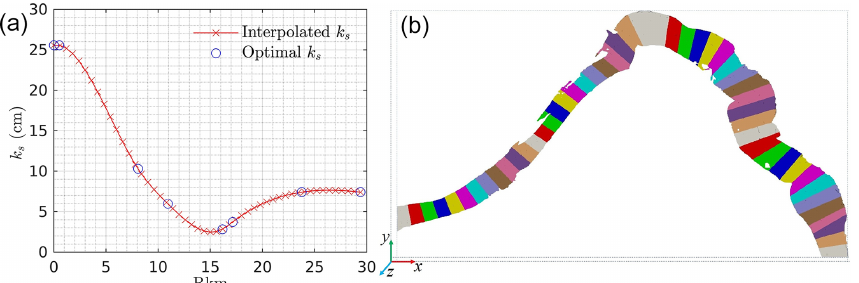
Figure A8. The roughness height on 50 pieces of stream interpolated from the six globally optimal roughness parameters (blue circle) (a) and the decomposition of the streambed into 50 pieces (b) .